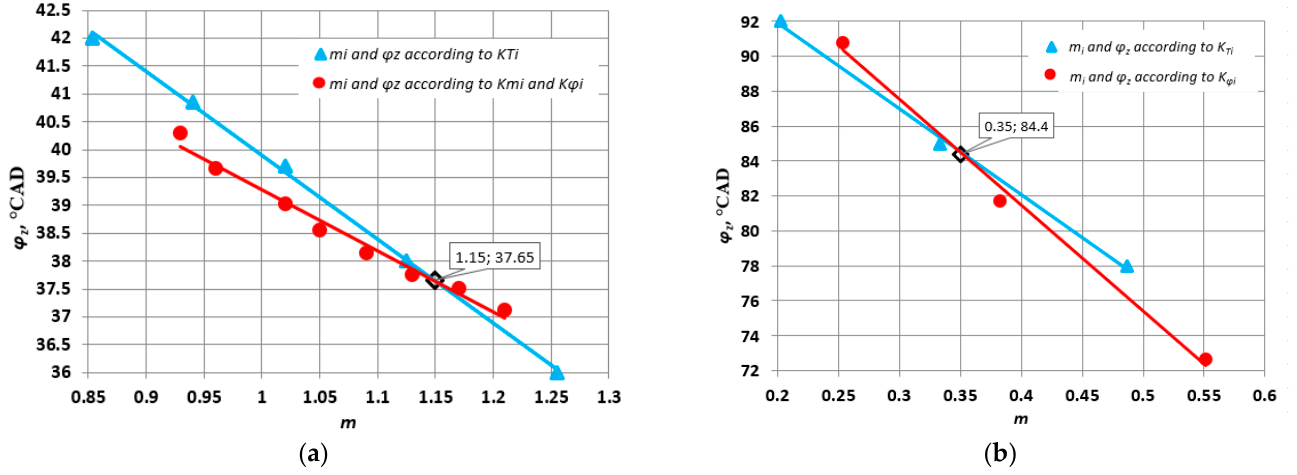
Figure 8. Evaluation of m i and φ zi parameter combination using trajectory crossing method: ( a )1Z 1.9 TDI engine; ( b ) 8V396TC4 engine.